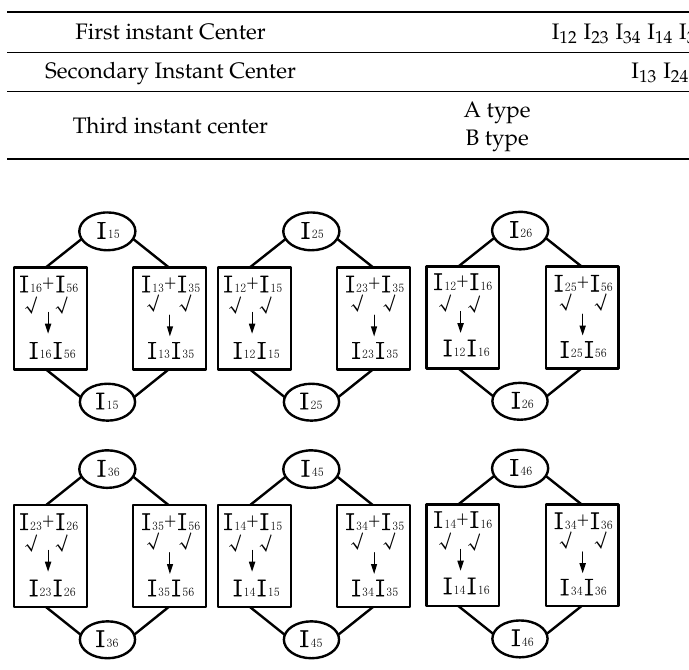
Figure 4. The instant center identification process graph of the Stephenson linkage.